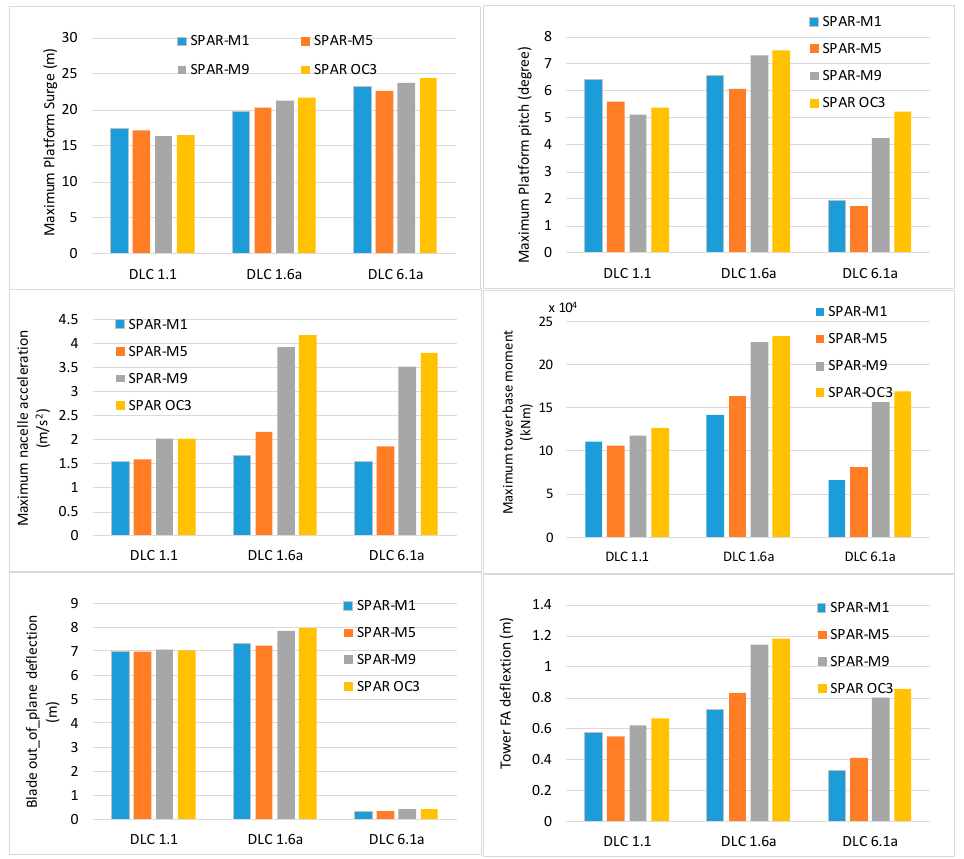
Figure 13. Ultimate loads and responses of the FOWT systems for three DLCs.